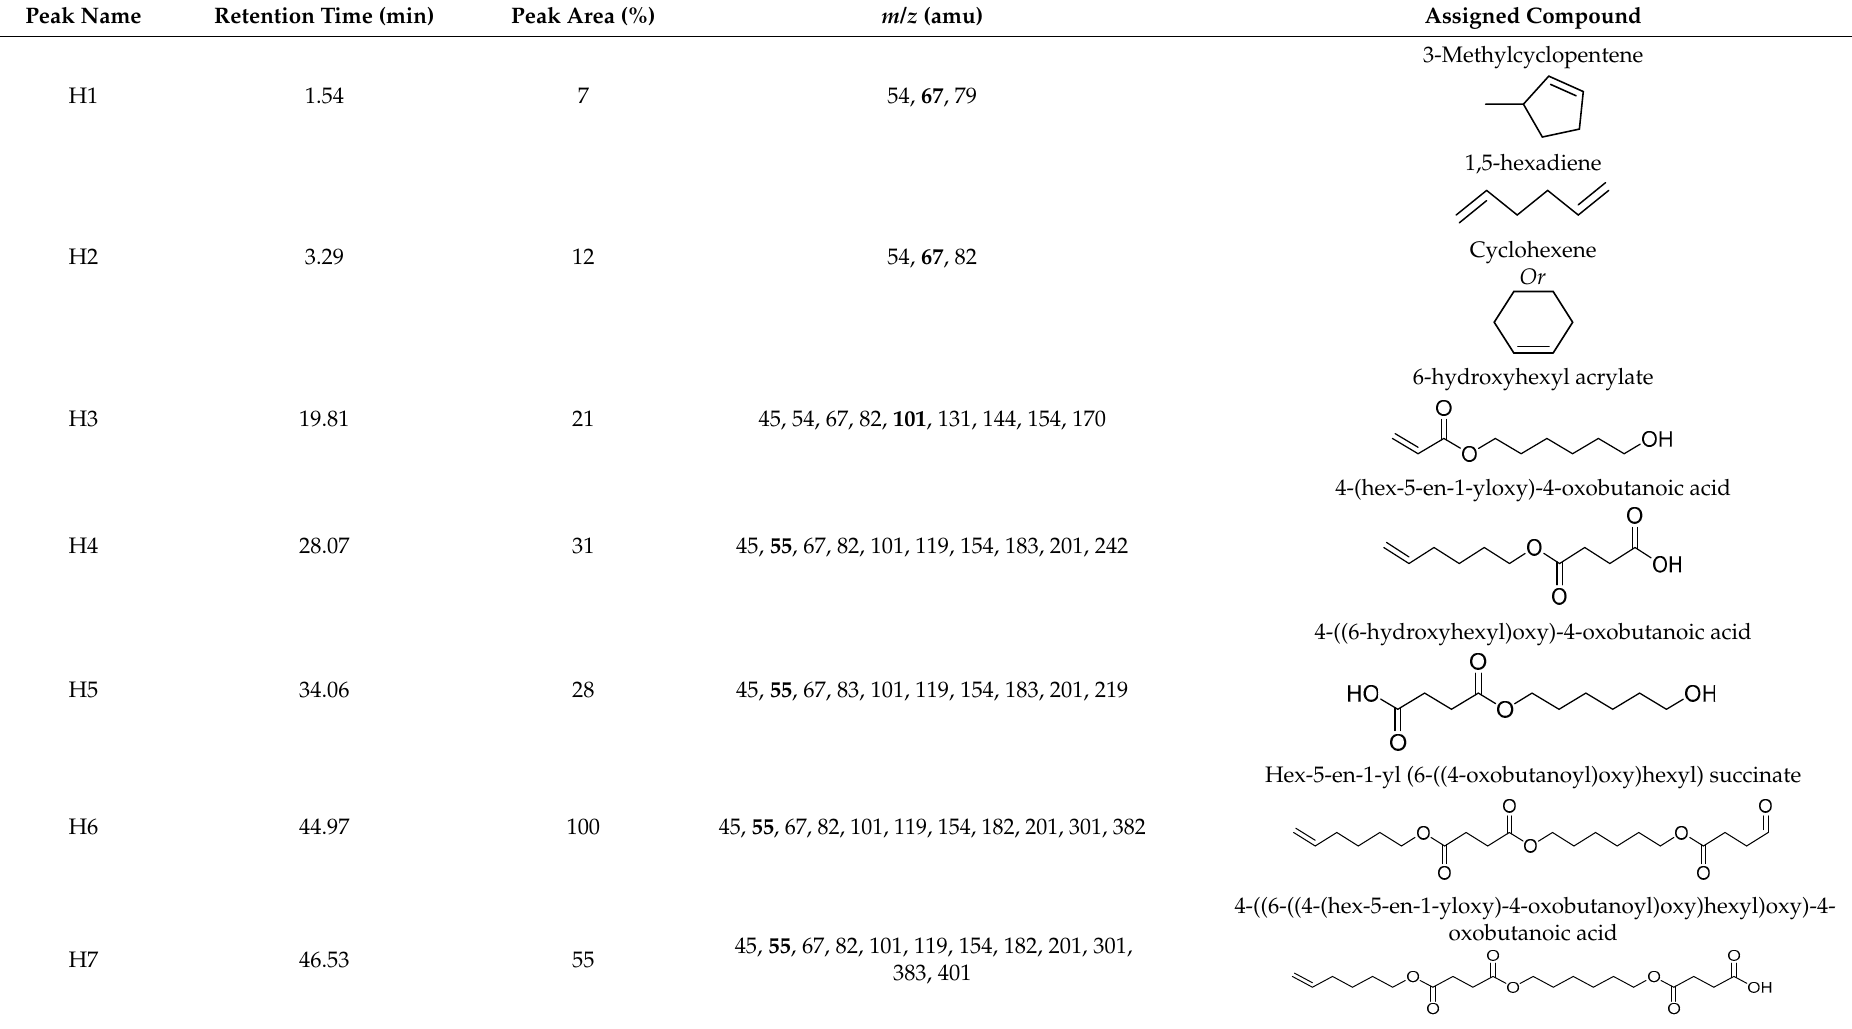
Figure 4. Mass spectra of major decomposition products of PBSu. Table 5. Thermal decomposition products of PHSu.